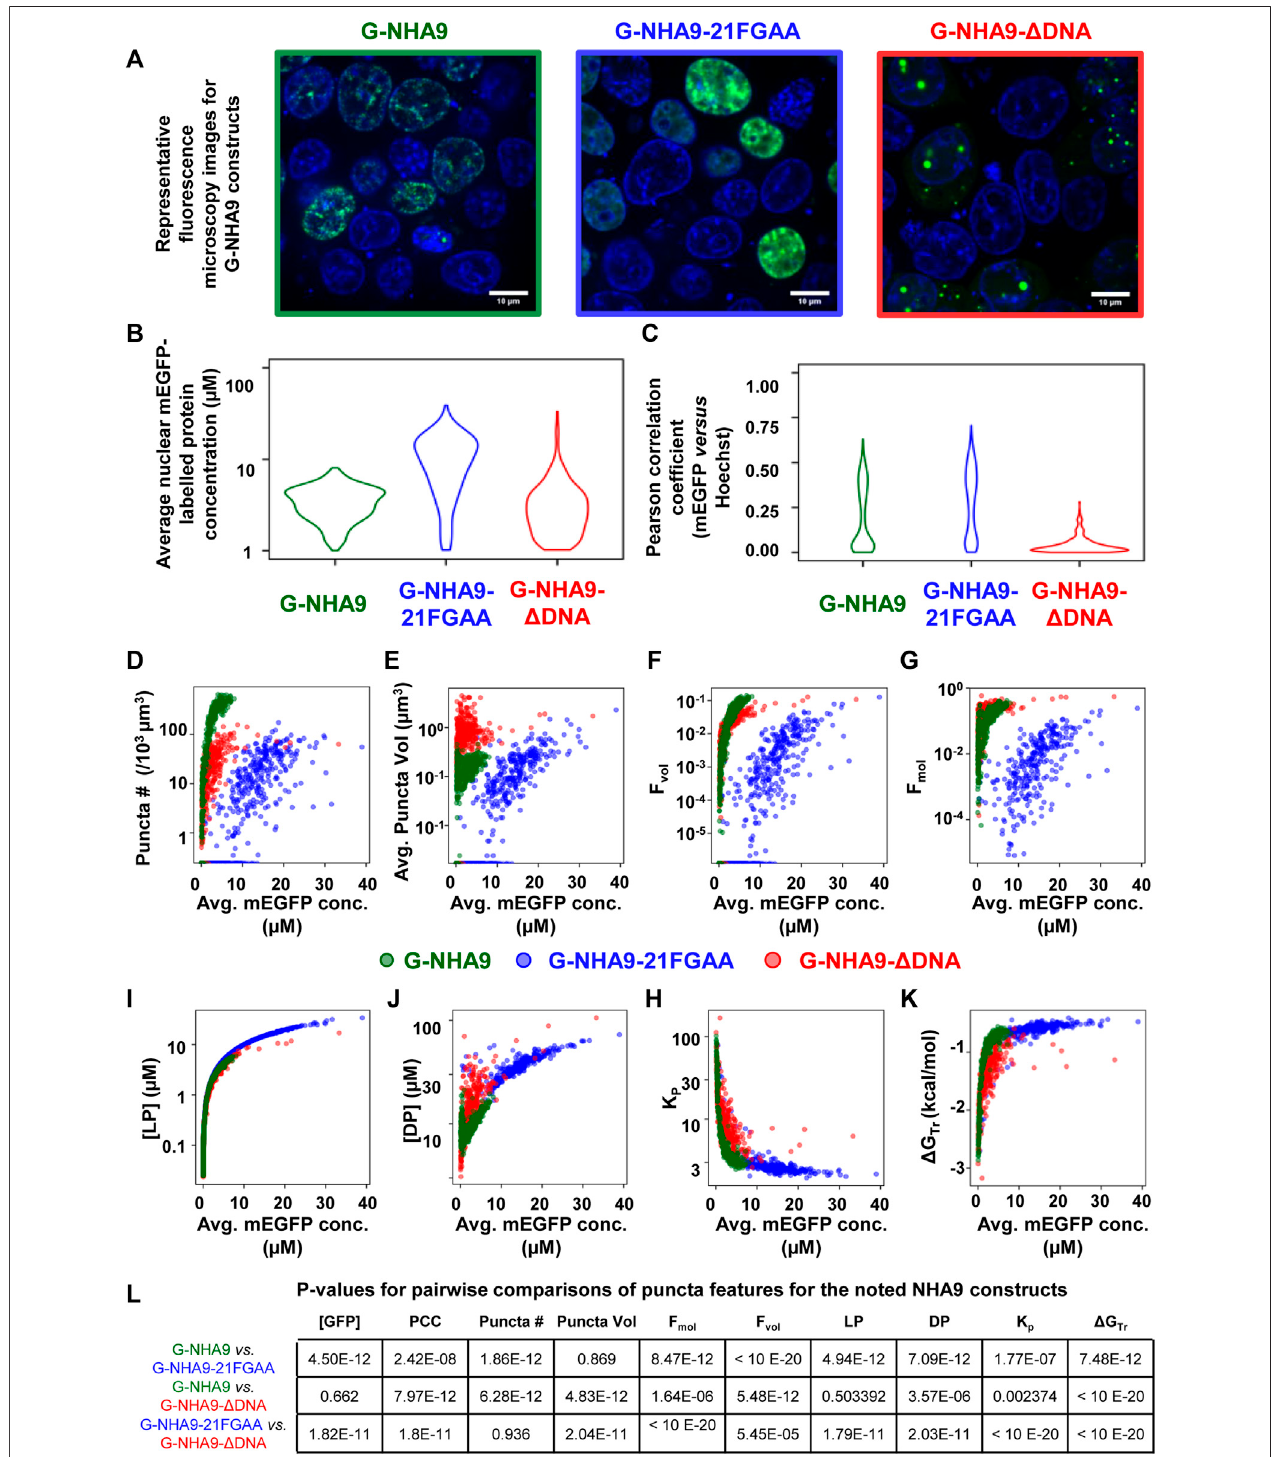
FIGURE 5 | Example Punctatools pipeline output. (A) Exemplary microscopy images illustrating differences in puncta features for G-NHA9 (green box, n = 1,004), G-NHA9-21FGAA (bluebox, n = 880), and G-NHA9- Δ DNA (red box, n = 849). The fl uorescence signals for theG-NHA9 constructs are illustrated in green and those for Hoechstdyeareshowninblue.ThePunctatoolspipelinequanti fi esrawimagestoextractparameterssuchas, (B) ,theapparentaveragenuclearconcentrationpercellof the fl uorescently-labeled biomolecule (mEGFP) and (C) , Pearson correlation coef fi cients (PCC) between fl uorescent channels (the Hoechst dye and mEGFP channels in these examples). Additional functions within Punctatools generate plots reporting features such as, (D) Puncta number; (E) Puncta volume; (F) Puncta